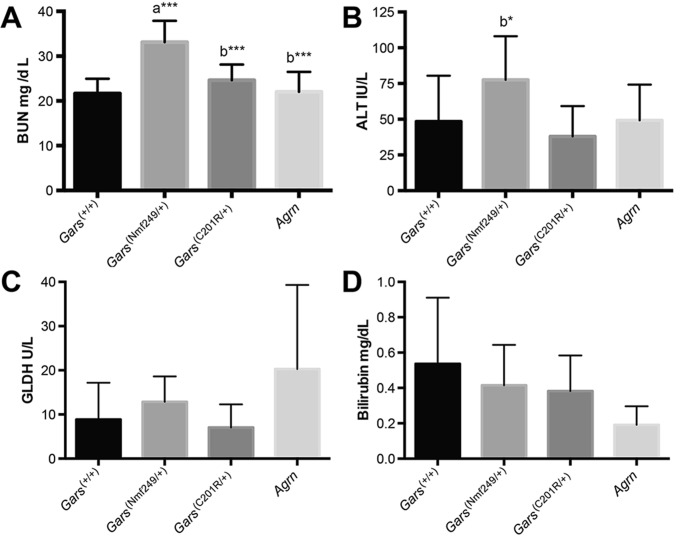
Serum indicators of liver and kidney function in neuromuscular disease model mice. (A) Blood urea nitrogen (BUN), an indicator of kidney function, is elevated GarsNmf249/+ mice, but not in the milder GarsC201R/+ allele, nor in Agrnnmf380 mice, a model of congenital myasthenic syndrome that causes severe neuromuscular dysfunction that is comparable to the GarsNmf249/+ mice. Both the milder Gars mice and the Agrn mutant mice had significantly lower BUN levels than the severe Gars mice. (B) The liver enzyme alanine transaminase (ALT) was also elevated in GarsNmf249/+ mice compared to the milder GarsC201R/+ mice, but neither GarsC201R/+ nor in Agrn mutant mice differ from control. (C,D) Other indicators of liver function, glutamate dehydrogenase (GLDH) and total bilirubin were highly variable in all gentoypes and did not show significant changes. N=11 wild-type, N=8 GarsNmf249/+, N=5 GarsC201R/+, and N=6 Agrn mice. ‘a’=different than control, ‘b’=different than GarsNmf249/+ *P≤0.05, **P≤0.01, ***P≤0.001. Error bars represent standard deviation from mean.